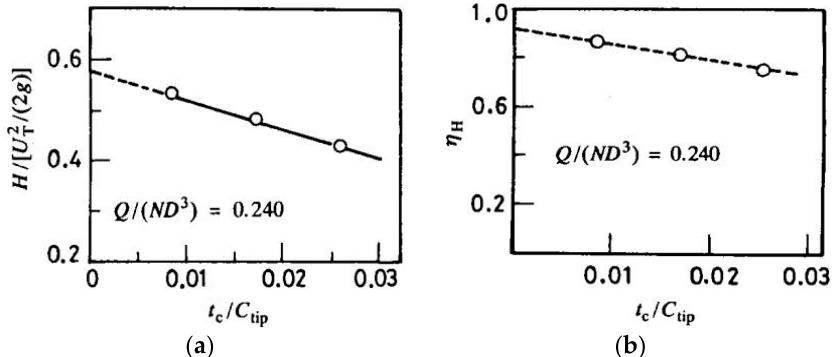
Figure 22. Pump head and efficiency versus tip-clearance size near design flow rate: ( a ) head; ( b ) efficiency [47].